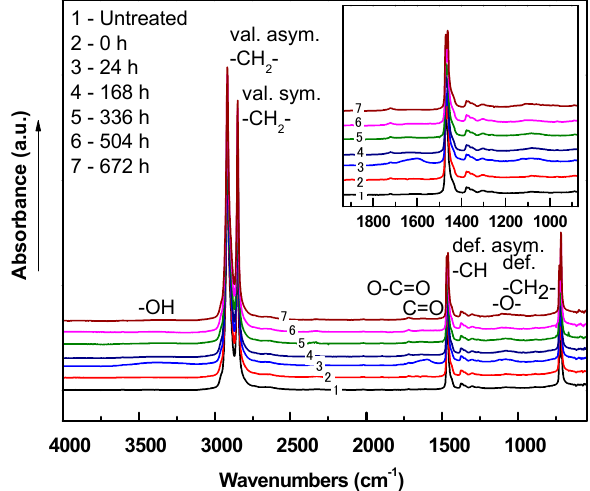
Figure 12. FTIR spectra of LDPE plasma treated for 120 s using air and stored in air.